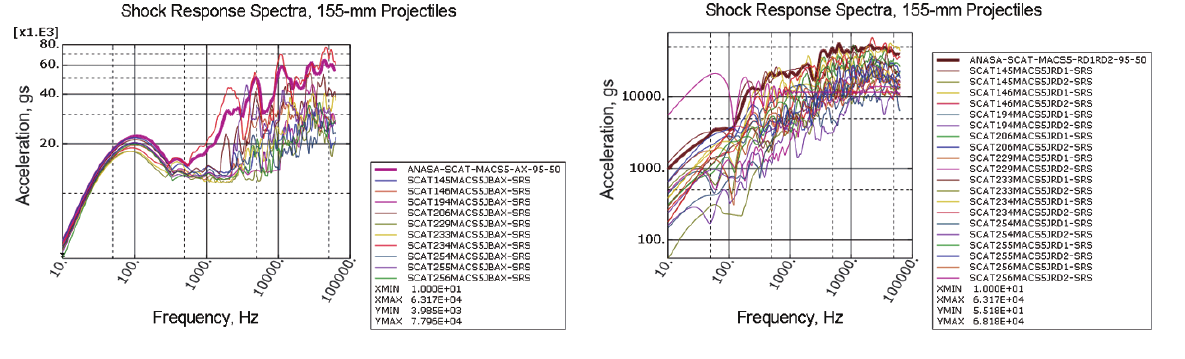
Fig. 7. Shock response, 10 Soft Catch Shots MACS 5, Axial, Q = 10. Fig. 8. Shock response, 10 Soft Catch Shots MACS 5, transverse, Q = 10.